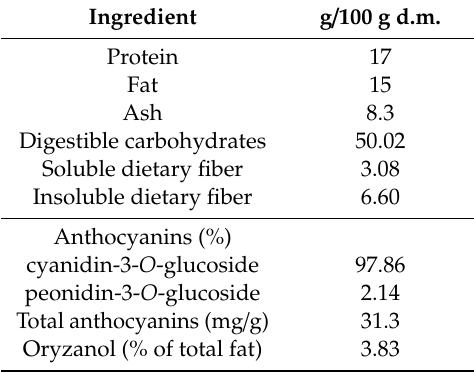
Table 3. Basic chemical composition of the black rice fraction and selected bioactive contents.